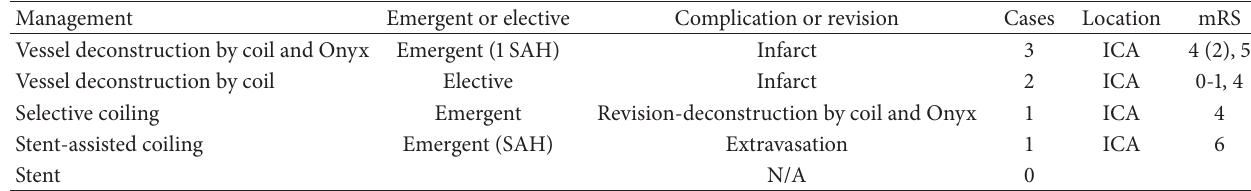
Table 2: Complications and revisions of pseudoaneurysm